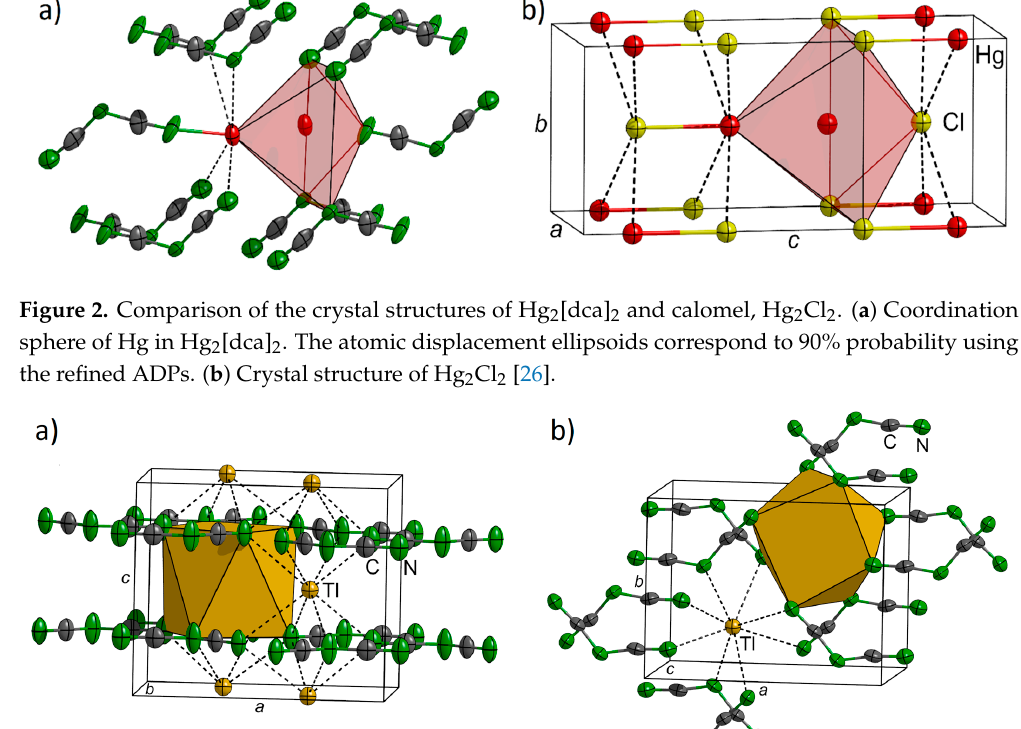
Figure 3. Crystal structure of Tl[dca] with ( a ) showing the view along c and ( b ) along b . The atomic displacement ellipsoids correspond to 90% probability using the refined ADPs.